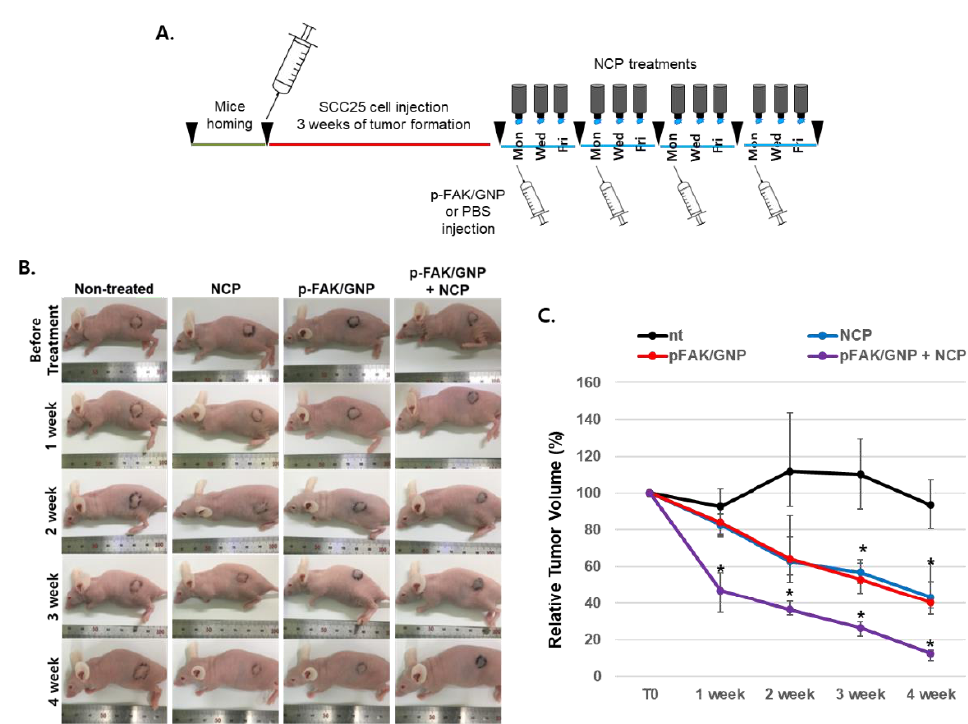
Figure 5. The anti-OSCC activity of the combinational treatment of p-FAK/GNP with NCP is faster and stronger than the single treatment of NCP or p-FAK/GNP in mice xenograft models. ( A ) A schematic diagram describing the animal experiments testing the anti-OSCC effect of p- FAK/GNP+NCP. After the tumor formation, p-FAK/GNP was injected once per week, and NCP was treated for 5 min on the tumor 3 times per week for 4 weeks. ( B ) The photographs showing external changes in the tumors in each group, which were taken before the treatment and after the last treat- ment of each week. The photographs shown are representative of each group ( n = 4). ( C ) A graph showing the relative tumor volume change of each group ( n = 4). The tumor volume of each group was measured after the photographs were taken. * p < 0.05.